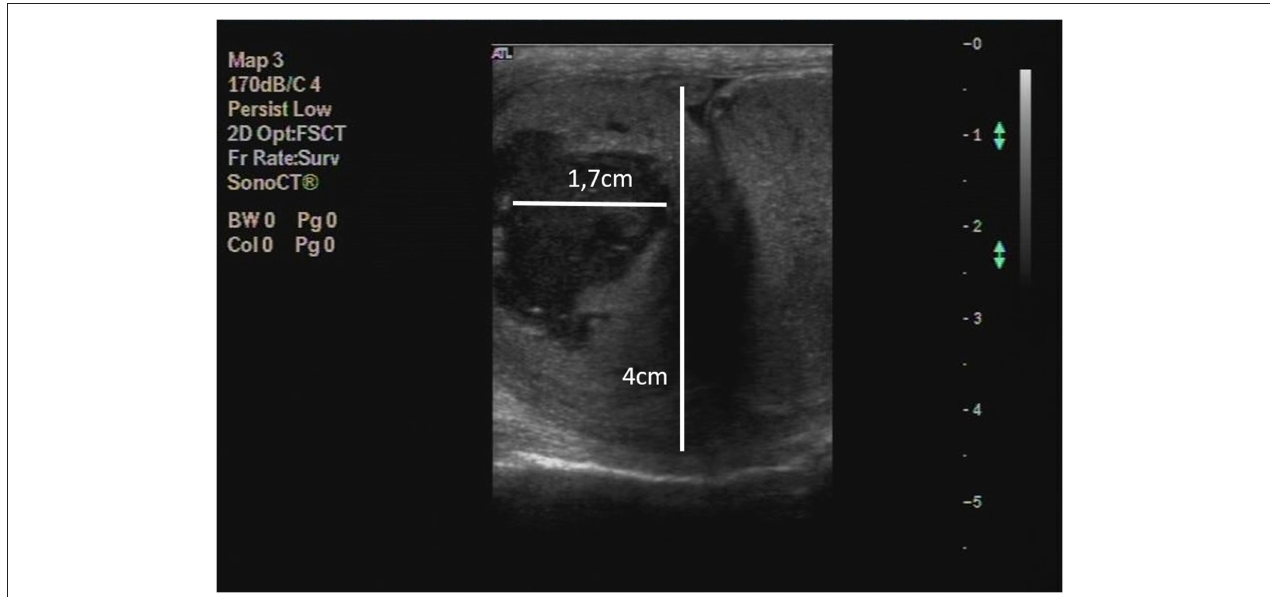
FIGURE 1 | Testicle and epididymis, dog. Diagnostic ultrasonography of the epididymis (4cm) with indication of one of the anechogenic areas (1.7